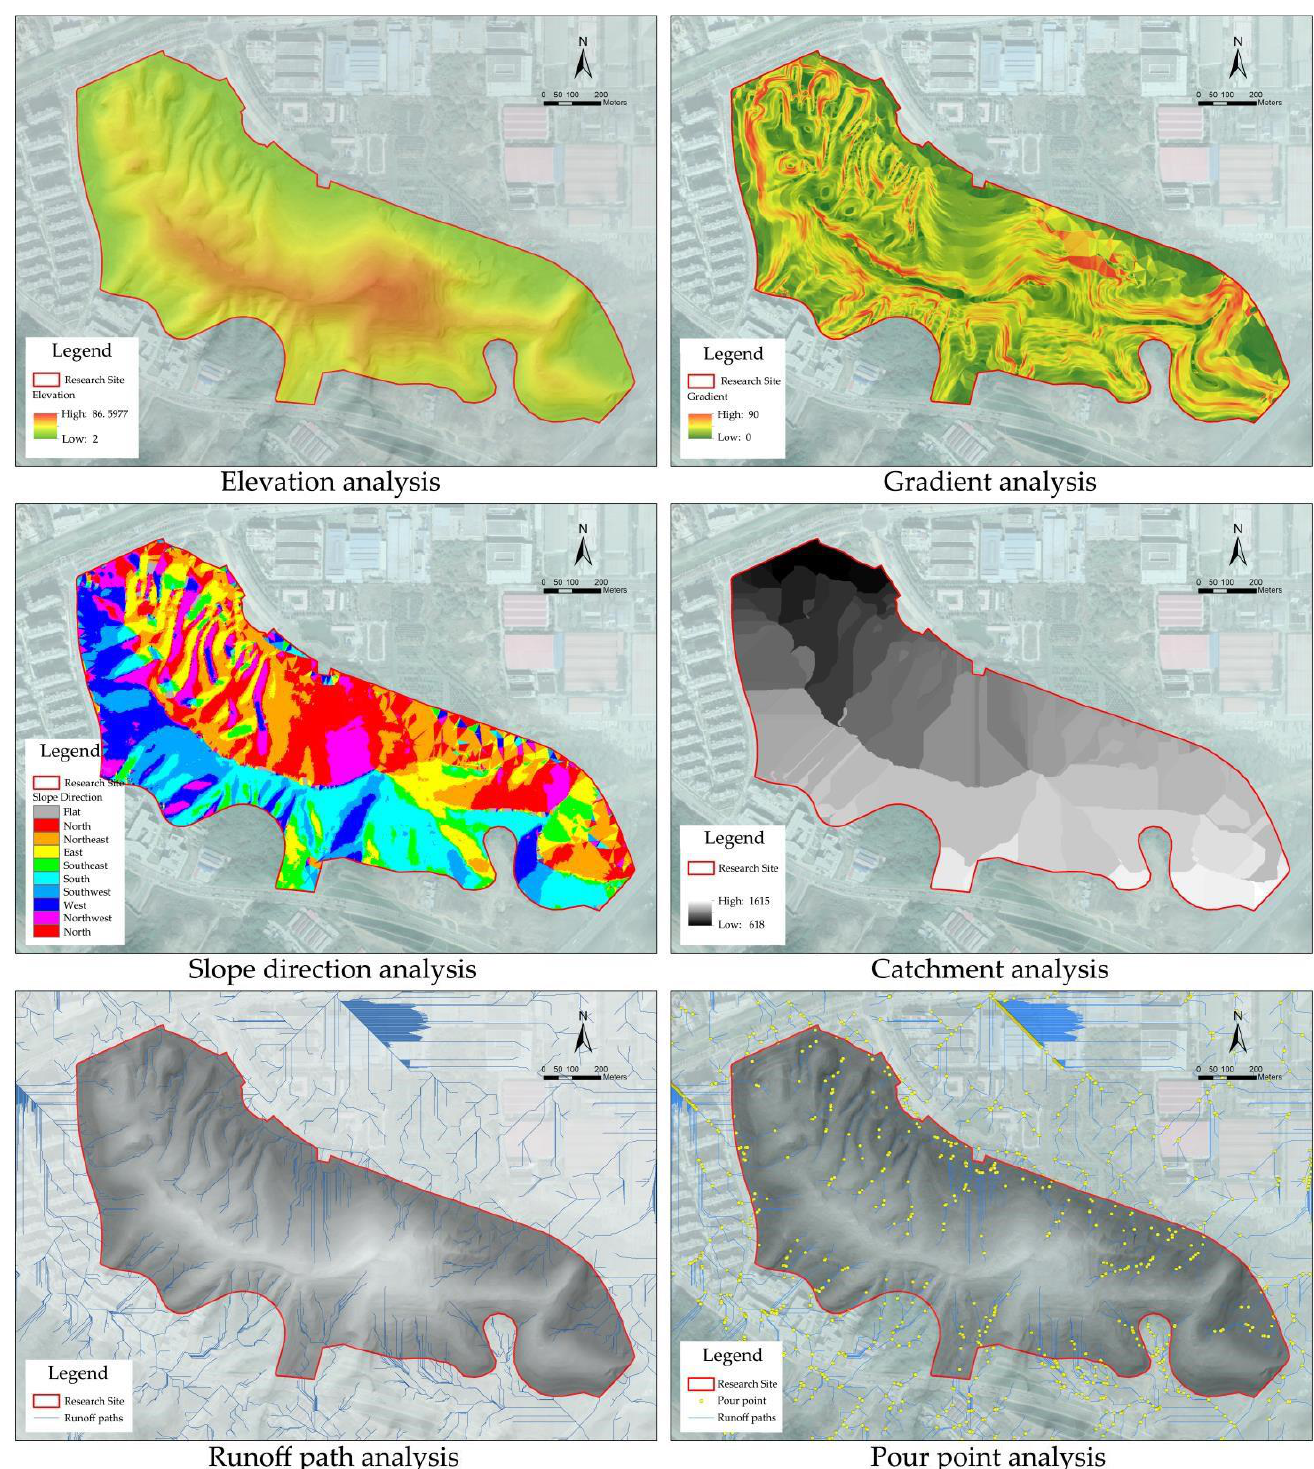
Figure 2. Topographical and Hydrological Analysis of Lijia Mountain.